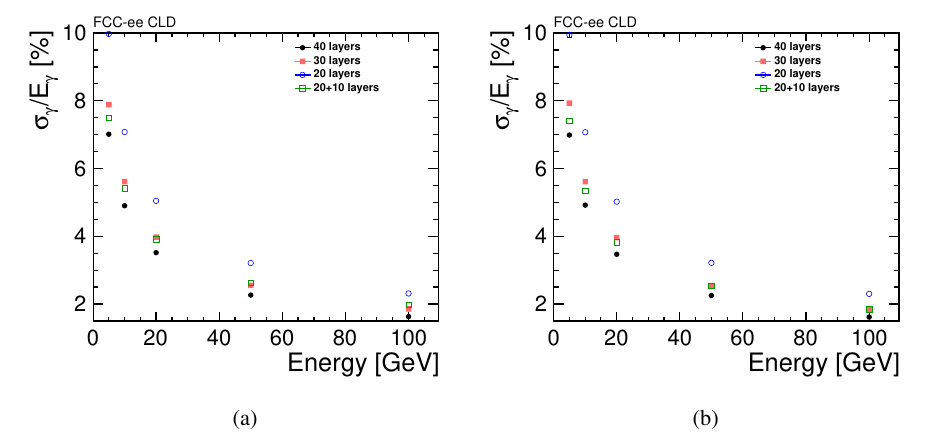
Figure 2: Photon energy resolution as a function of energy in the (a) barrel and (b) endcap regions. The results are shown for di ff erent ECAL layer